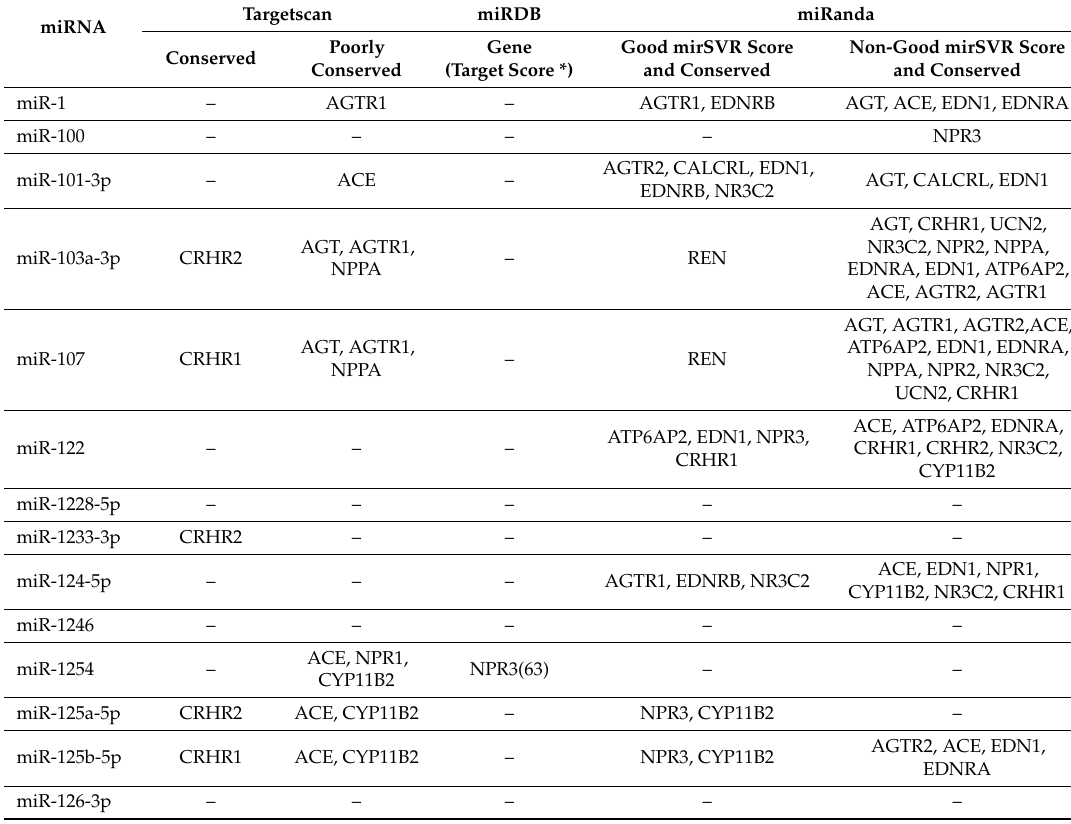
Table 9. Predicted neurohormones targets for 71 heart failure related